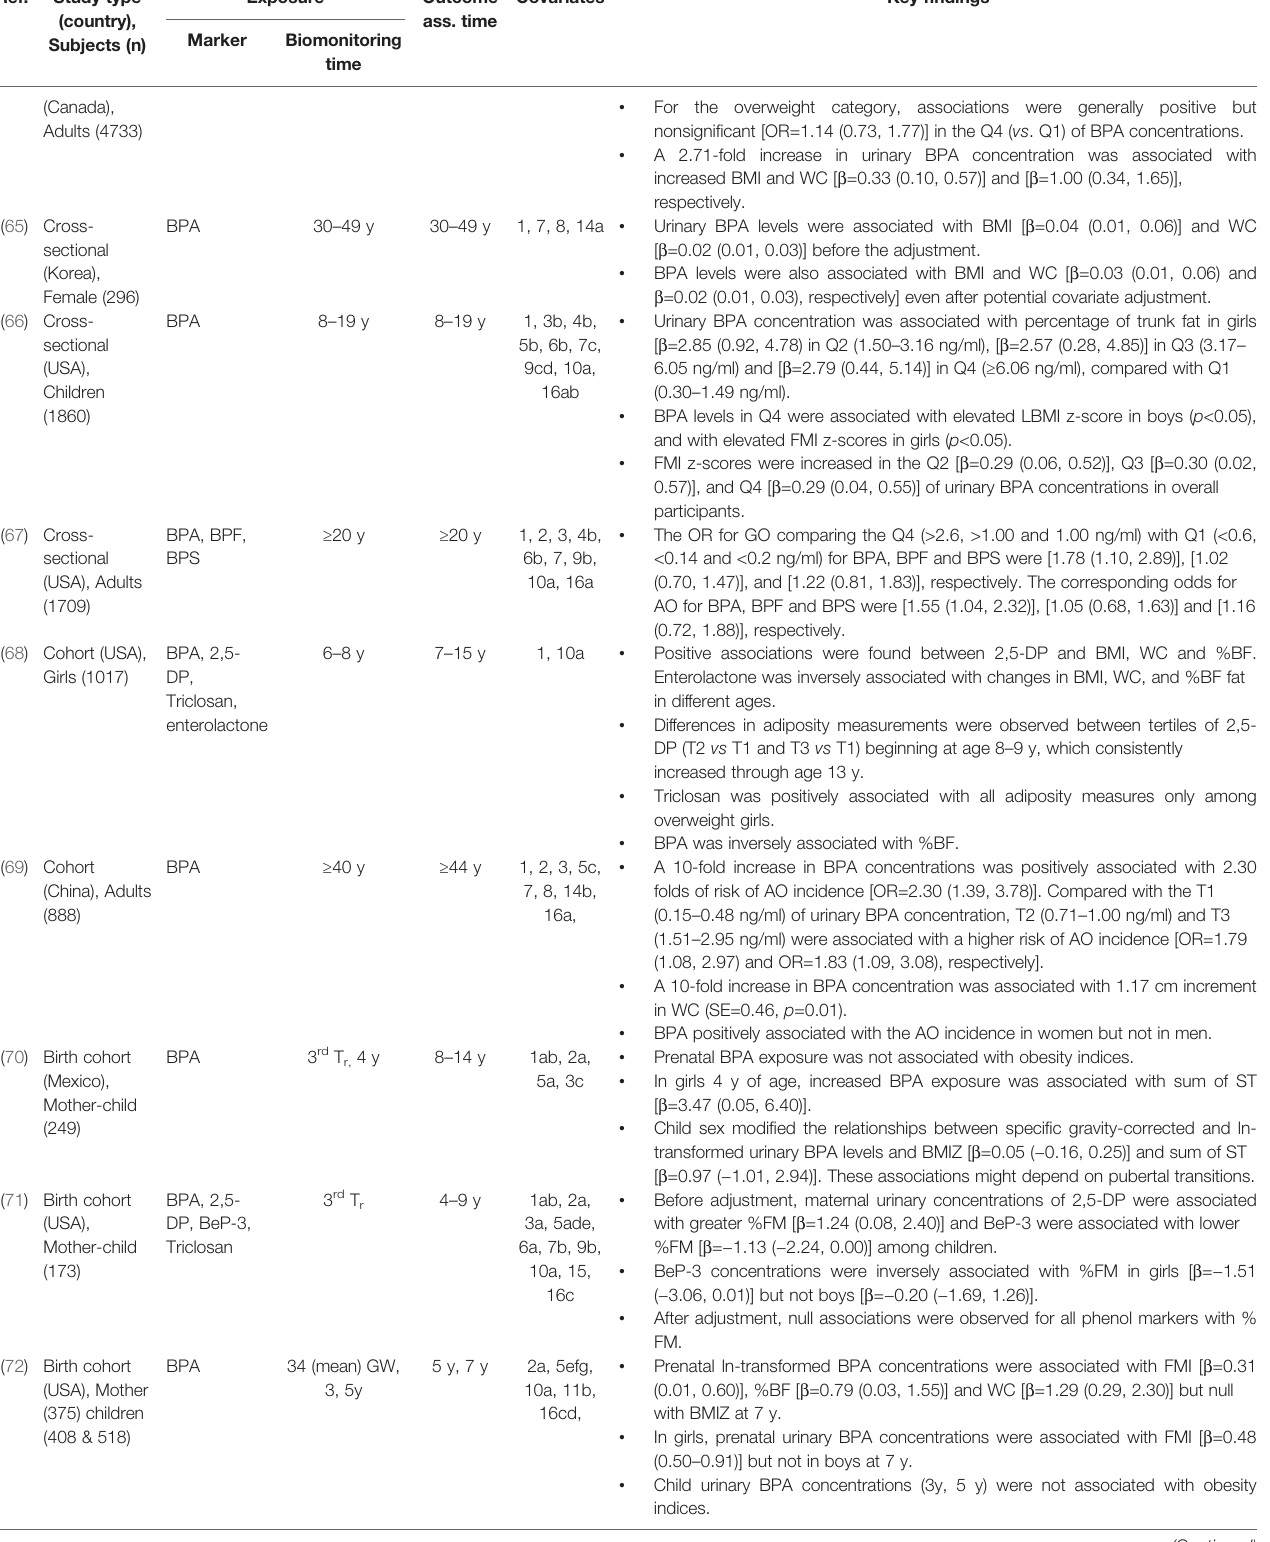
For the overweight category, associations were generally positive but nonsigni fi cant [OR=1.14 (0.73, 1.77)] in the Q4 ( vs . Q1) of BPA concentrations. (cid:129) A 2.71-fold increase in urinary BPA concentration was associated with increased BMI and WC [ b =0.33 (0.10, 0.57)] and [ b =1.00 (0.34, 1.65)], respectively.